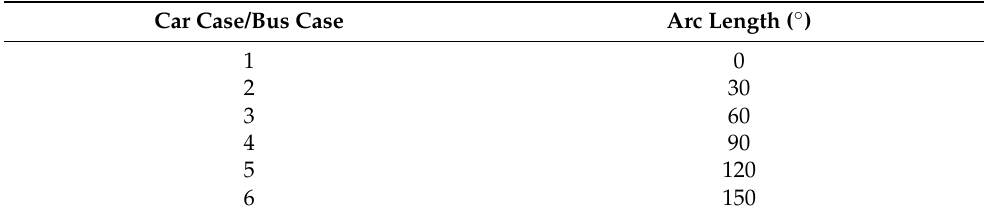
Table 1. Simulation cases for car case and bus